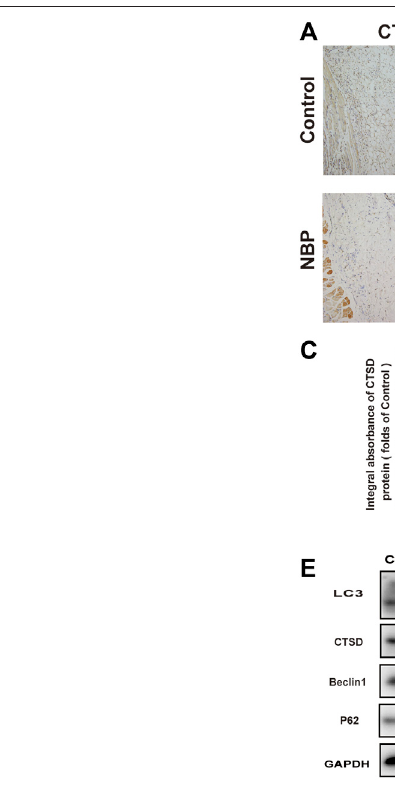
FIGURE 5 | NBP inhibits autophagy in multiterritory perforator fl ap. (A) IHC for CTSD in the ischemic fl ap of the control and NBP-treated animals(200X);scale bar, 50 μ m. (B) Autophagosome(LC3,red)immuno fl uorescentstainingofcellsinthechoke Ⅱ zoneinthecontrolandNBPgroups.NucleiarecounterstainedwithDAPI(blue) (scale bar, 20 μ m). (C) Optical density values of CTSD in each group. (D) Percentage of LC3-positive cells in each group. (E) and (F) Western blot for Beclin1, CTSD, SQSTM1/p62, and LC3 in the ischemic fl ap of the control and NBP groups. Gels were run under similar experimental conditions and edited only for clarity. Values are shown as mean ± SEM, n (cid:1) 6 per group. * p < 0.05 and ** p < 0.01 vs. control